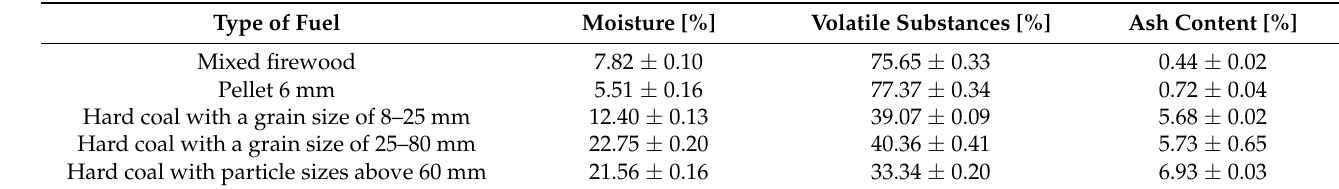
Table 1. Analysis of the fuels used for the experiment.